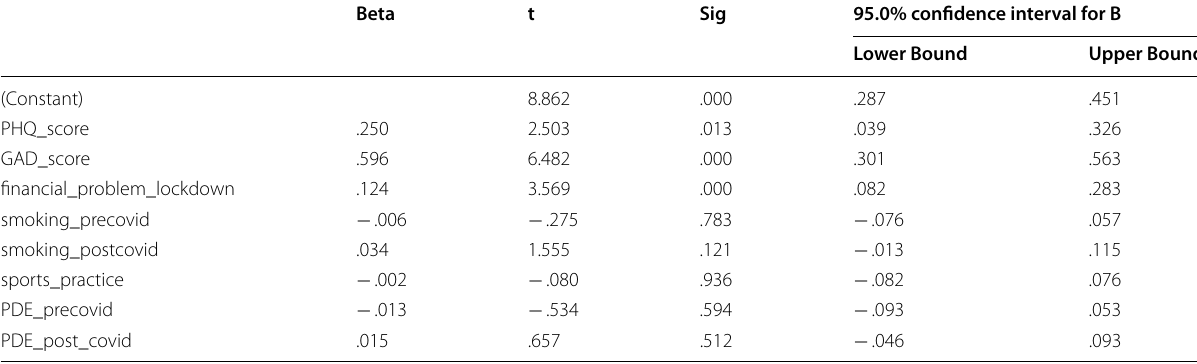
Table 3 Linear regression